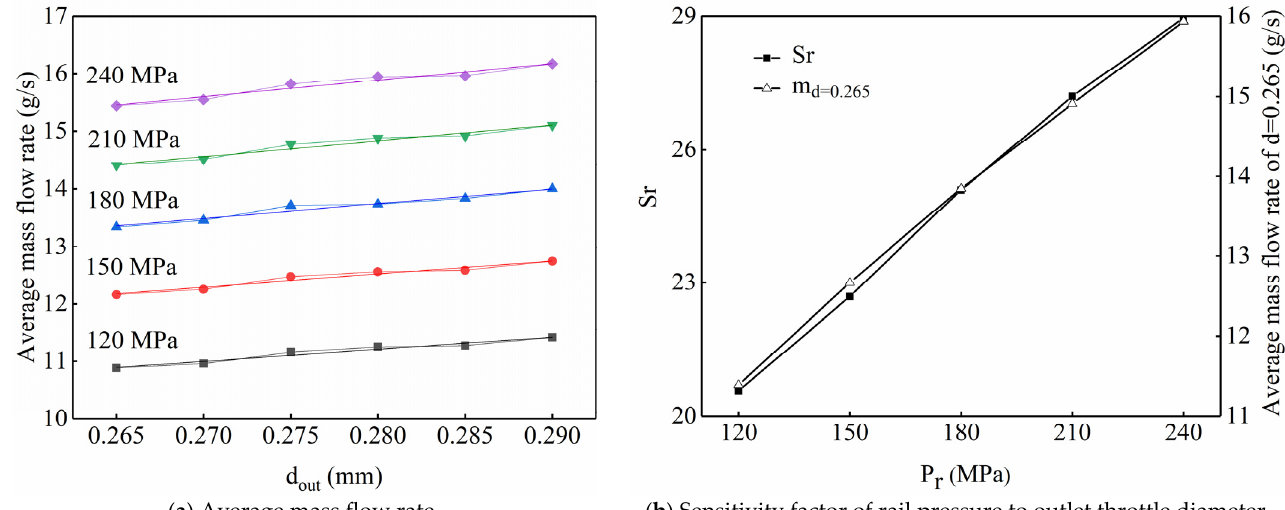
Figure 15. The influence law of rail pressure and outlet throttle diameter deviation on the coupling of mass flow rate of outlet throttle.